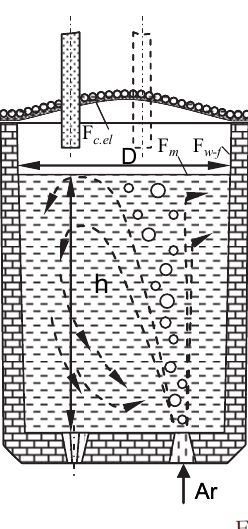
Figure 1: Ladle furnace scheme and heat transfer areas.